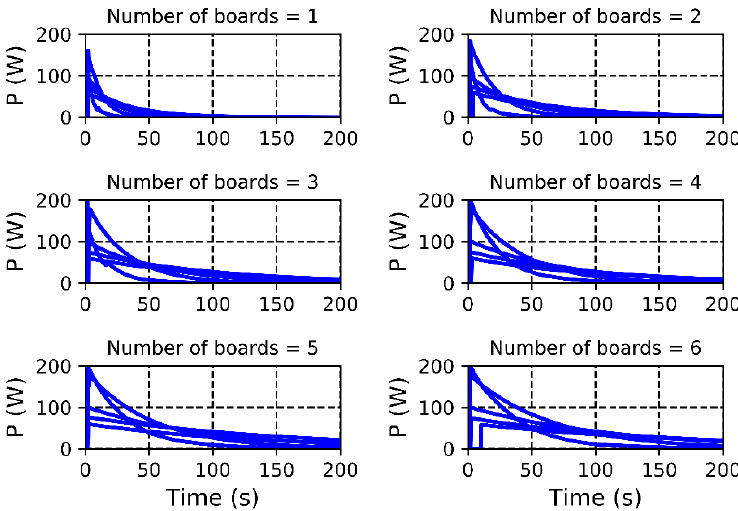
Figure 26. Power while discharging according to the number of boards connected.